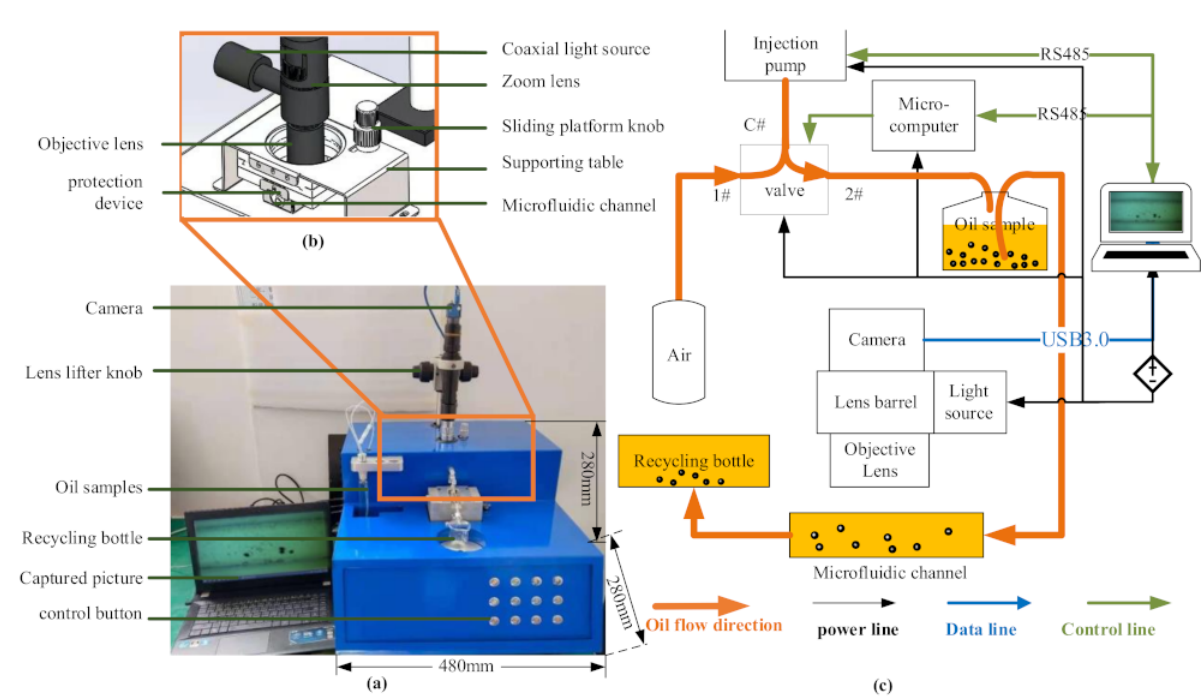
Figure 3. ( a ) Complete hardware system of WKAS, ( b ) partial assembly diagram of microfluidic channel, and ( c ) WKAS working principle